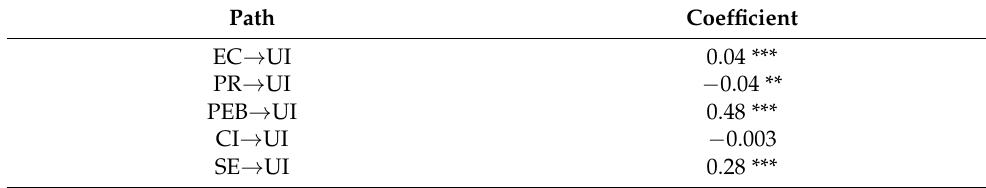
Table 3. Indirect effects of endogenous and exogenous variables on use intention.